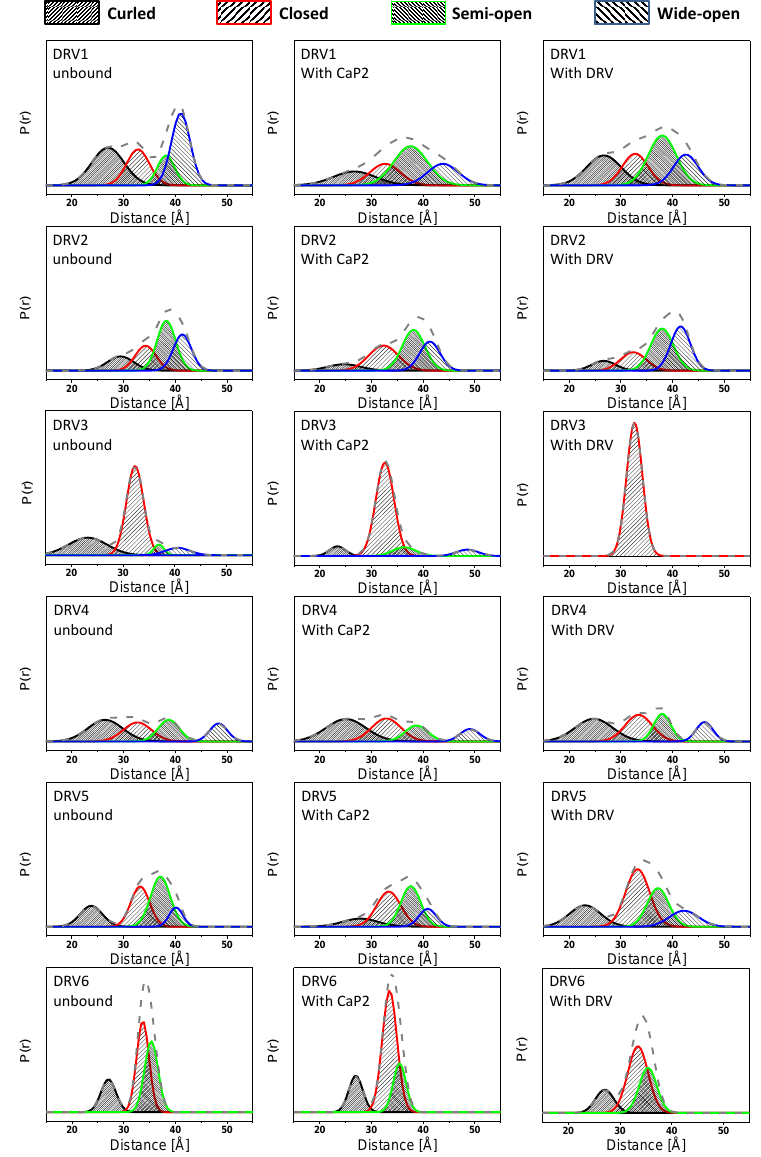
Figure 4. Population analysis of normalized DEER distance profiles for each construct unbound, upon addition of non-hydrolysable CaP2 inhibitor or DRV inhibitor. The gray dashed line represents the overall population profile shown in Figure 3. The curled open conformation is rendered in black with tight forward hashes. The closed population is drawn with red with moderate spaced forward hashes. The semi-open conformation is represented by a green line with tight back hash lines, and the wide-open conformation is in blue with moderately spaced back hash lines. Given the signal-to-noise ratio for collected DEER echo traces, the error for populations is ± 3% P(r). Full details of data processing are given in the supporting information and follow the protocol described previously [55,56].